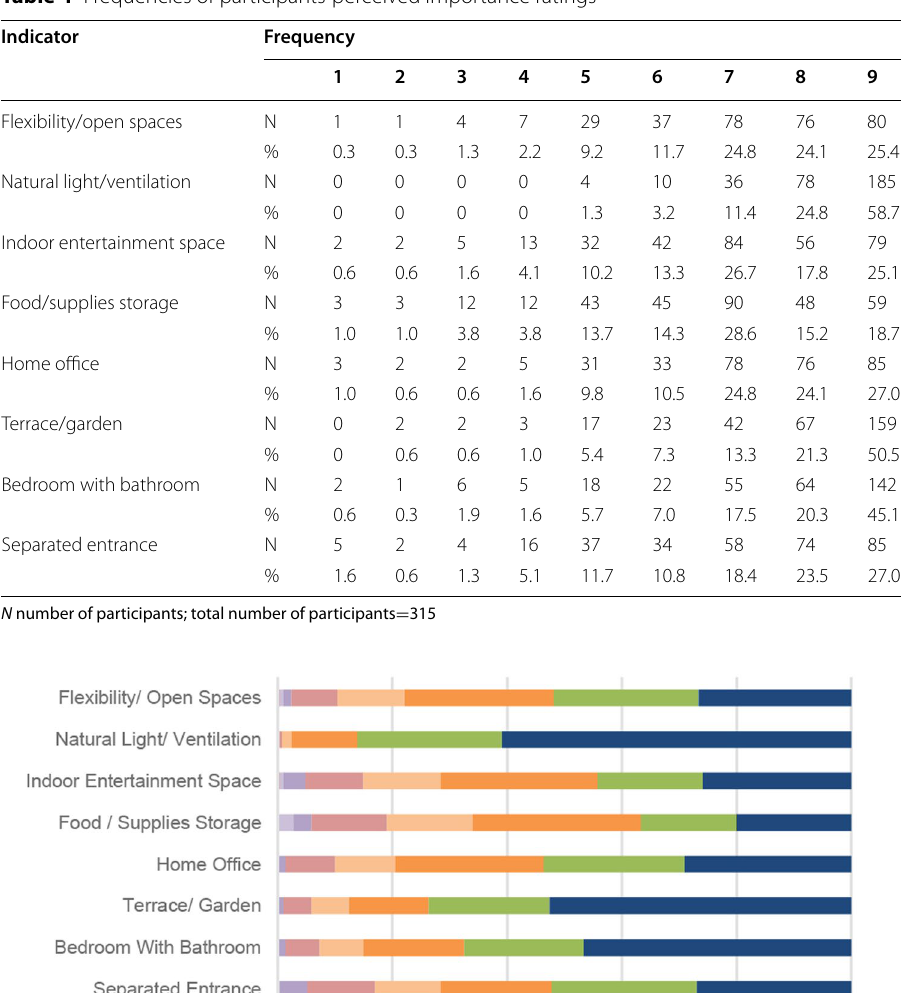
Table 4 Frequencies of participants’ perceived importance ratings Indicator